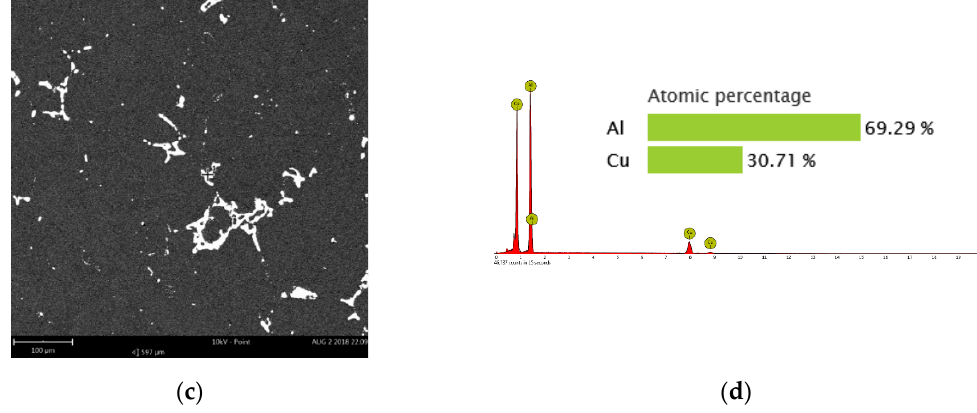
Figure 2. Initial state of the deformed samples: ( a ) optical microstructure (OM) and grain boundary (GB) figure; ( b ) misorientation angle frequency; ( c ) SEM micrograph; ( d ) energy disperse spectroscopy (EDS) analysis.